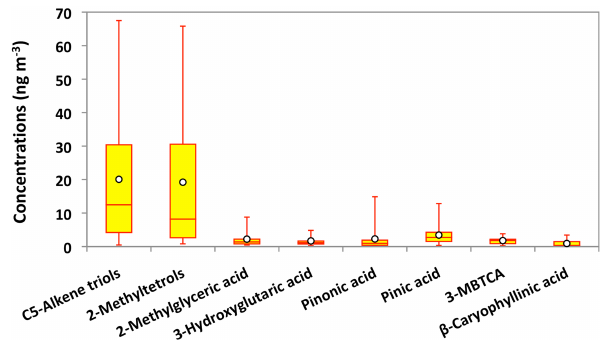
Figure 12. Molecular distributions of biogenic secondary organic aerosol tracers in PM 2 . 5 aerosols collected in central Alaska. See Fig. 5 for the description of the box-and-whisker diagram.